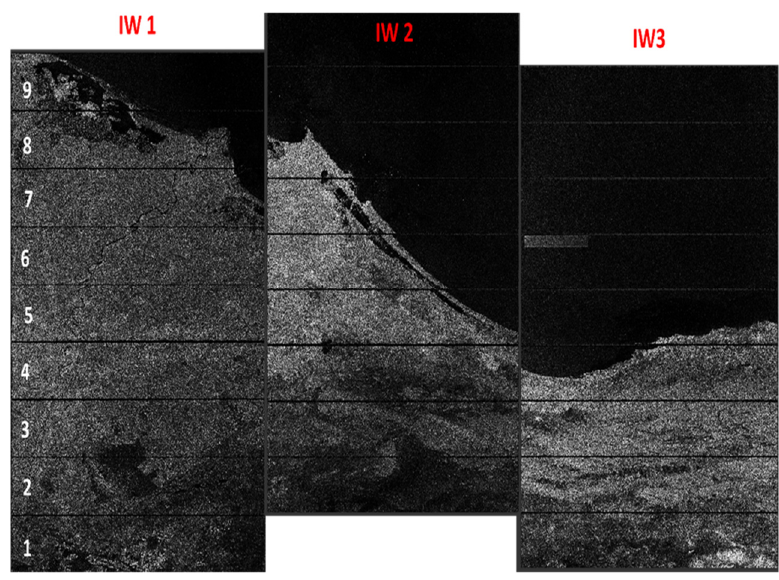
Figure 2. Sub-swaths (red) and bursts (white) of Sentinel-1 products of the study